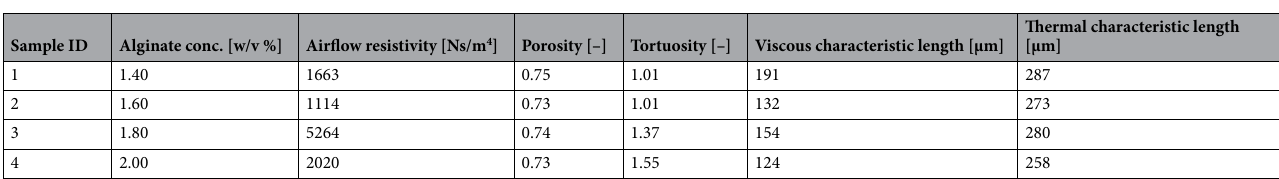
Table 4. Alginate variation—JCA model